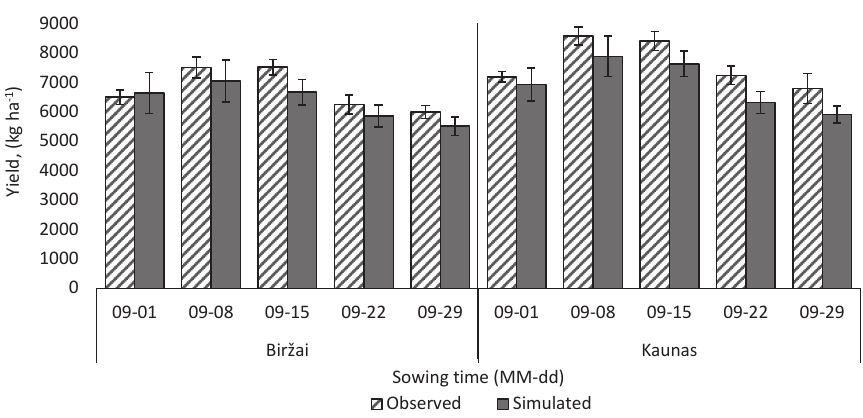
Fig. 5. Harvested and simulated yield (at maturity) at different sowing